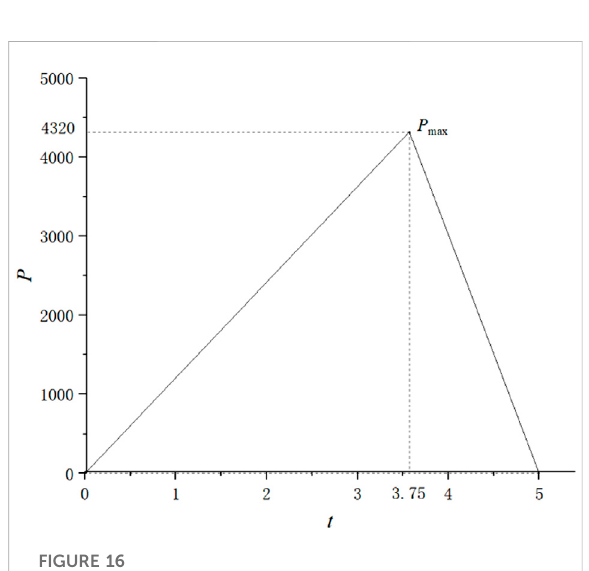
FIGURE 16 Equivalent triangular load diagram of